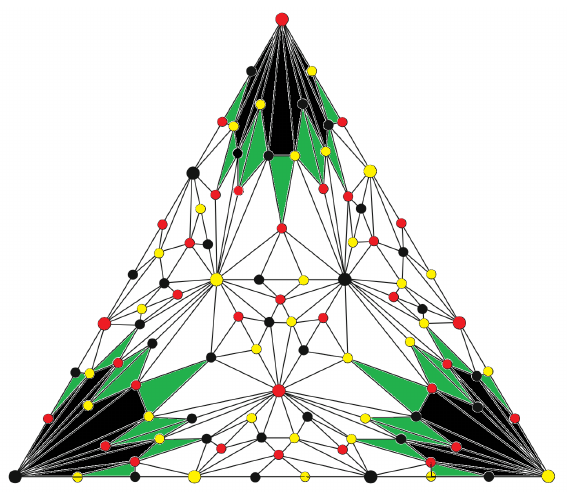
Figure 3. C -extended and C